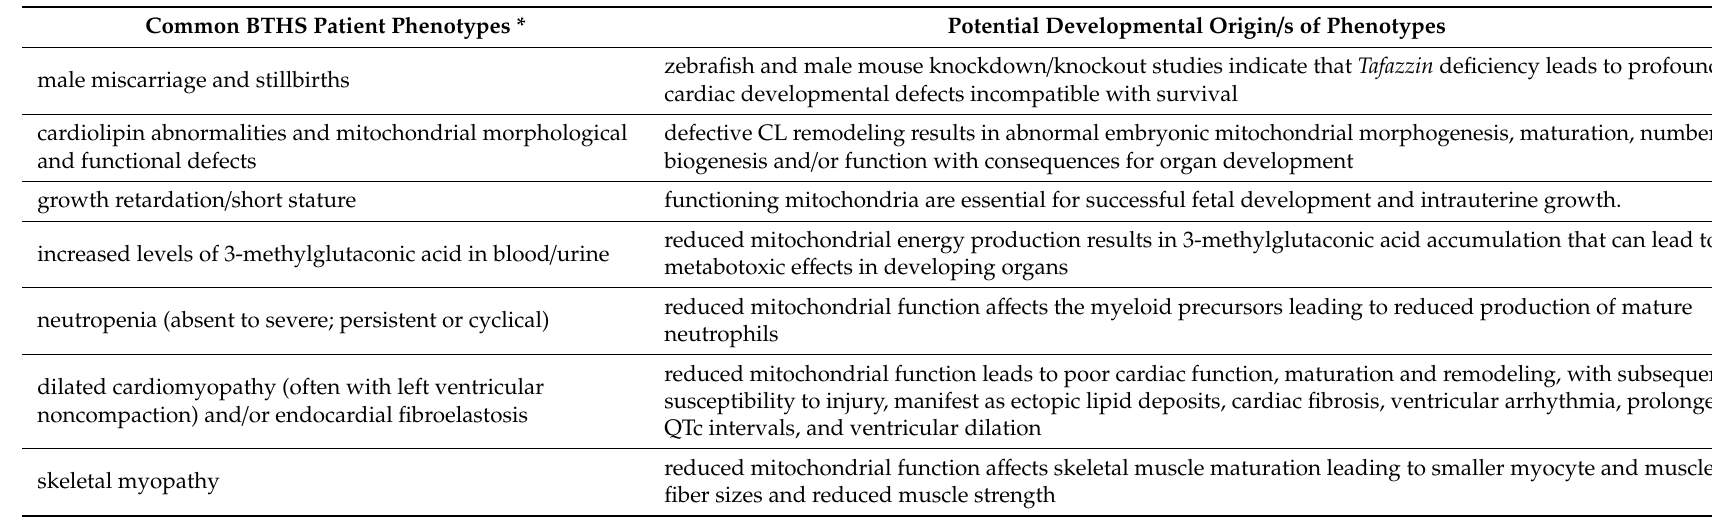
Table 2. Lists the most common male BTHS patient phenotypes and their possible in utero and perinatal developmental